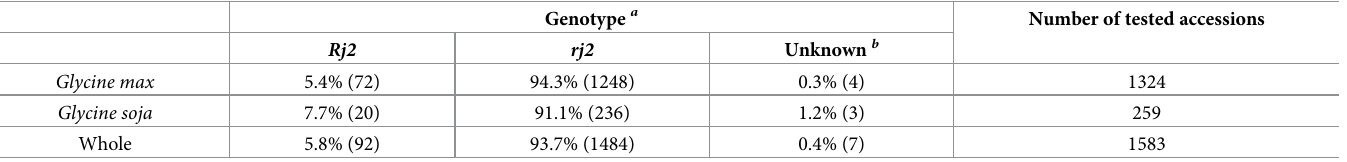
Table 1. Rj2 -genotype in soybean germplasm detected by SNP